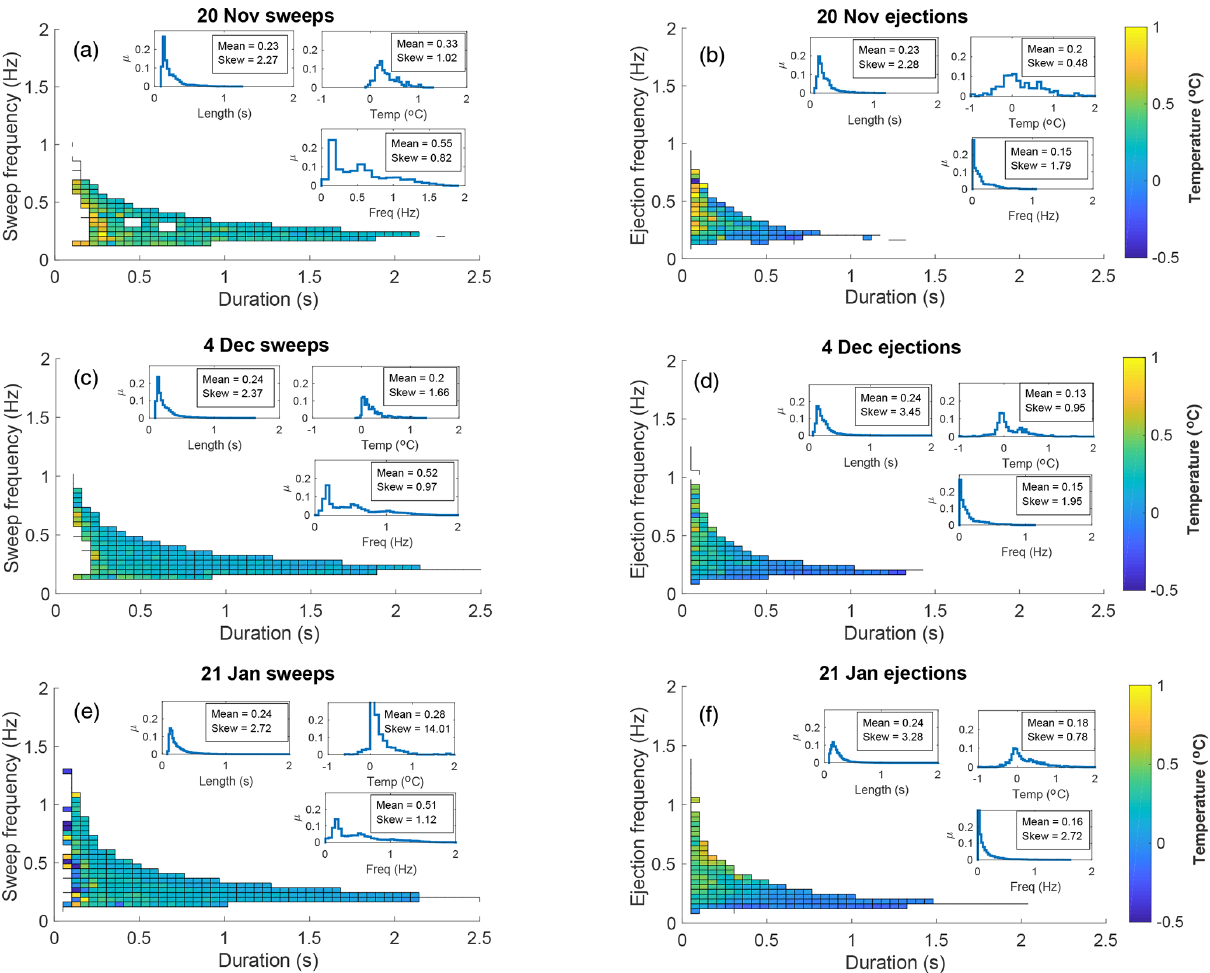
the left side of Fig. 3i show a group of sweeps that were 1 ◦ C warmer than the mean temperature of the 20 cm anemometer (bright yellow), but in Fig. 4i, the same group of sweeps were 0.5 ◦ C colder than the 140 cm anemometer mean (dark blue). Color scales are equivalent in Figs. 3 and 4. This effect is further supported by the mean anemometer temperatures de- tailed in Table